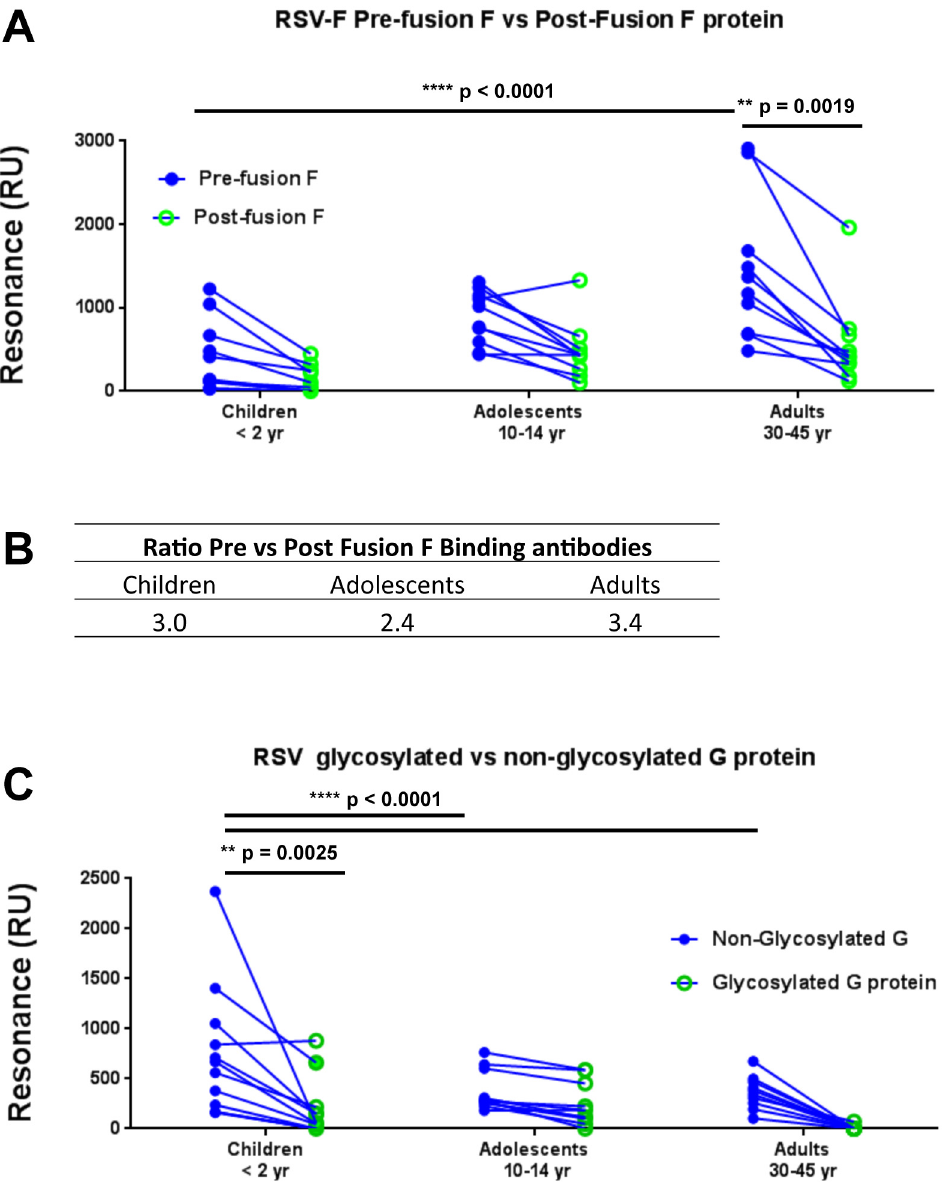
Fig 6. SPR based analysis of RSV-F and RSV-G purified proteins reactivity with human sera from of different age groups. (A) Serum samples collected from children ( < 2 years), adolescents (10 – 14 years), and adults (30 – 45 years), were analyzed for total binding to purified pre-fusion RSV-F (blue) or post-fusion RSV-F (green) protein by SPR. The pre-fusion RSV F (DS-Cav1) was produced in 293F cells and encodes amino acids 26 – 513 Δ 110 – 136. Post-fusion RSV-F protein was obtained from Sino biologicals and encodes amino acids 22 – 529 Δ 110 – 136. (B) Ratio of serum binding to RSV pre-fusion vs post-fusion F protein in different age groups by SPR. (C) Binding to non-glycosylated RSV-G (blue) vs glycosylated RSV-G (green). The RSV-A2-G (67 – 298) ectodomains were produced in bacterial or mammalian 293F cells. Total antibody binding is represented in SPR resonance units. Individual sample reactivity to different F proteins (A) or to RSV-G proteins (C) are shown by connected lines. Statistical significant differences of antibody reactivity between different age groups or within group are depicted with p